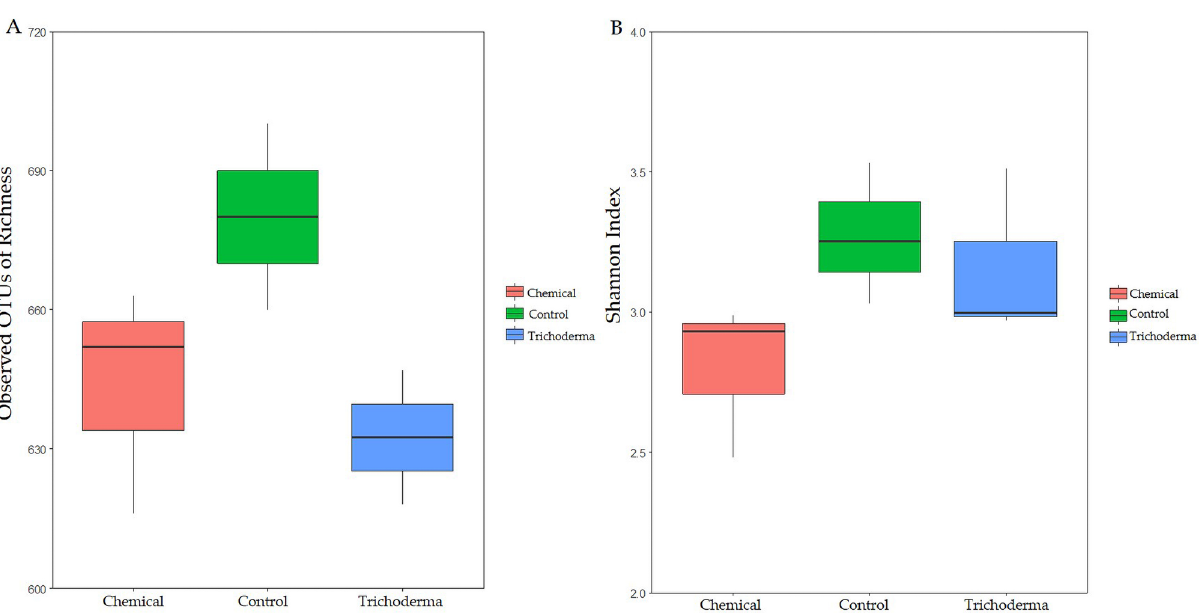
Figure 3. The diversity and richness of the fungal community in wheat rhizosphere soil under different treatments i.e. control seed dressing (Control), chemical fungicide seed dressing (Chemical) and T. atroviride HB20111 seed dressing ( Trichoderma ). Observed OTUs of Richness of different treatments ( A ) and Shannon index of different treatments ( B